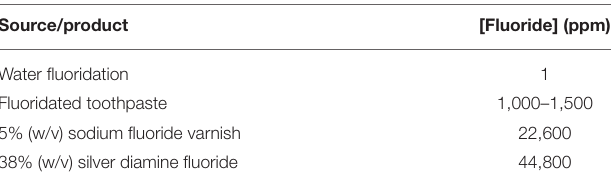
TABLE 1 | Fluoride contents (ppm) of fluoridated tap water and some typical oral health